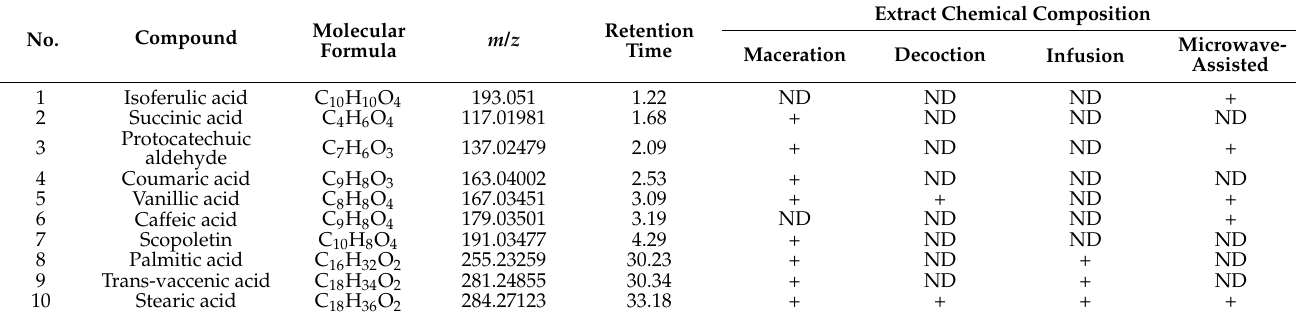
Table 1. Detected compounds in different Terfezia claveryi aqueous extracts using UPLC-ESI-MS.